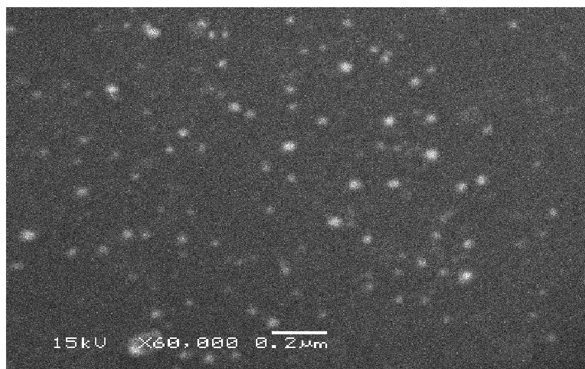
Figure 7: SEM photograph of V. jatamansi shoot AgNPs.